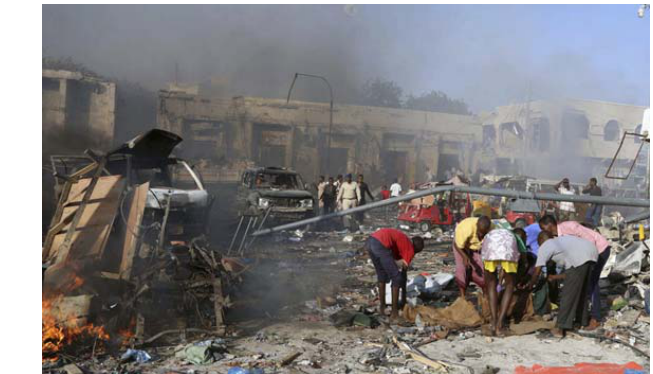
Figure 2 – Consequences of the VBIED attack in Mogadishu Рис . 2 – Последствия подрыва автомобиля в Могадишо Слика 2 – Последице напада импровизованом експлозивном направом у возилу